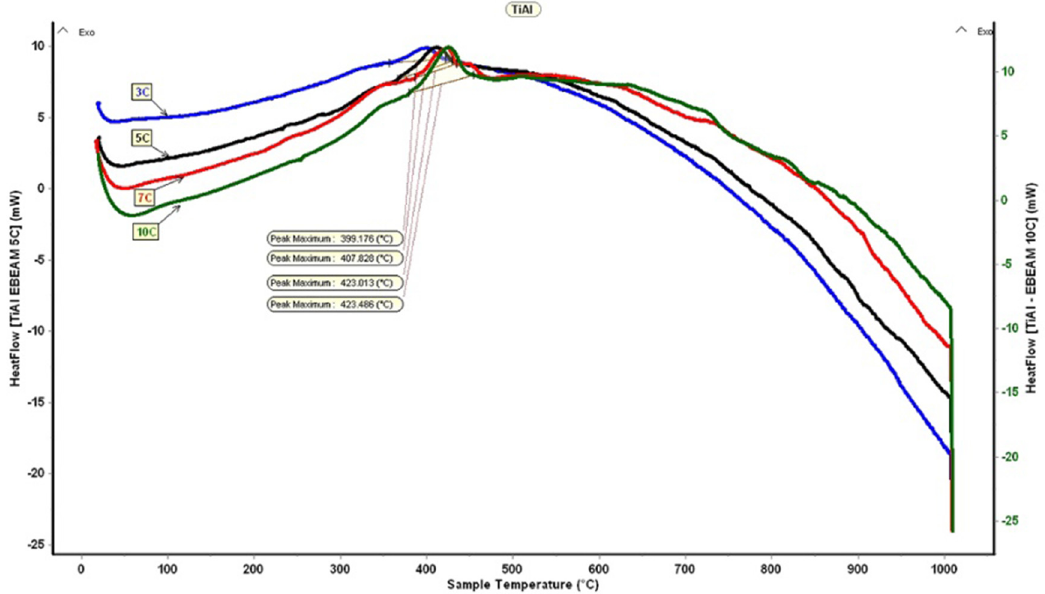
Fig. 3. DSC curves for heating rates 3, 5, 7 and 10 ° Cmin (cid:1) 1 of EB-PVD multi-layered TiAl nanostructured coatings.